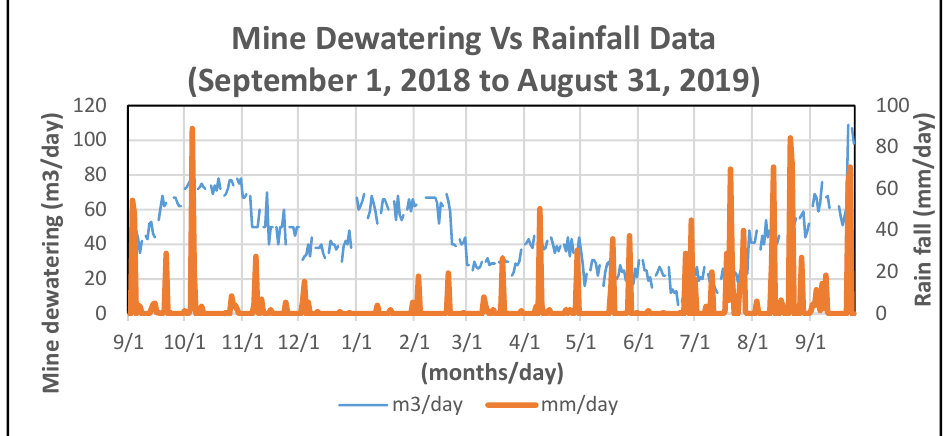
Figure 27. Monthly cumulative precipitation and discharge data (1 September 2018 to 31 August 2019).